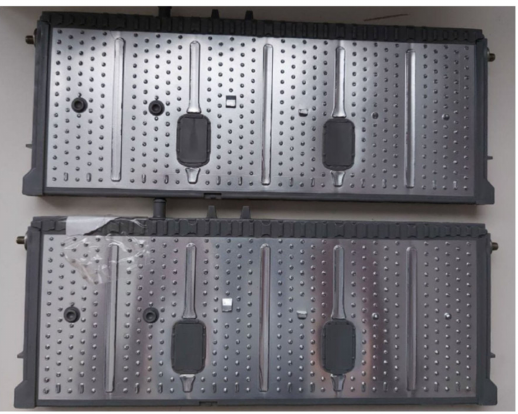
Figure 8. Detailed view of the assembly of a designed PCB mounted in the rack.